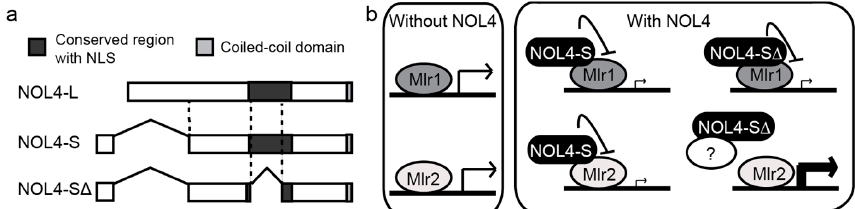
Figure 4. Mouse NOL4 splicing variants have different functions. ( a ) Schematics of the splicing variants of mouse NOL4. N-terminal region in NOL4-L is spliced out in NOL4-S and NOL4-S Δ . Major part of the conserved region containing NLS is spliced out in NOL4-S Δ . Adapted with permission from [23]; ( b ) A model describing how Mlr1 and NOL4 regulate transcription. Left panel: Without NOL4, Mlr1, and Mlr2 show transactivation activities. Right panel: When NOL4 variants are present, NOL4-S directly binds to Mlr1 and Mlr2, and inhibits the transactivation activity. NOL4-S Δ does not directly bind to Mlr2, but it may bind to another cofactor (represented by “?” in the figure), possibly CtBP proteins which suppress the activity of Mlr2, and thereby indirectly increase the transcription activity.